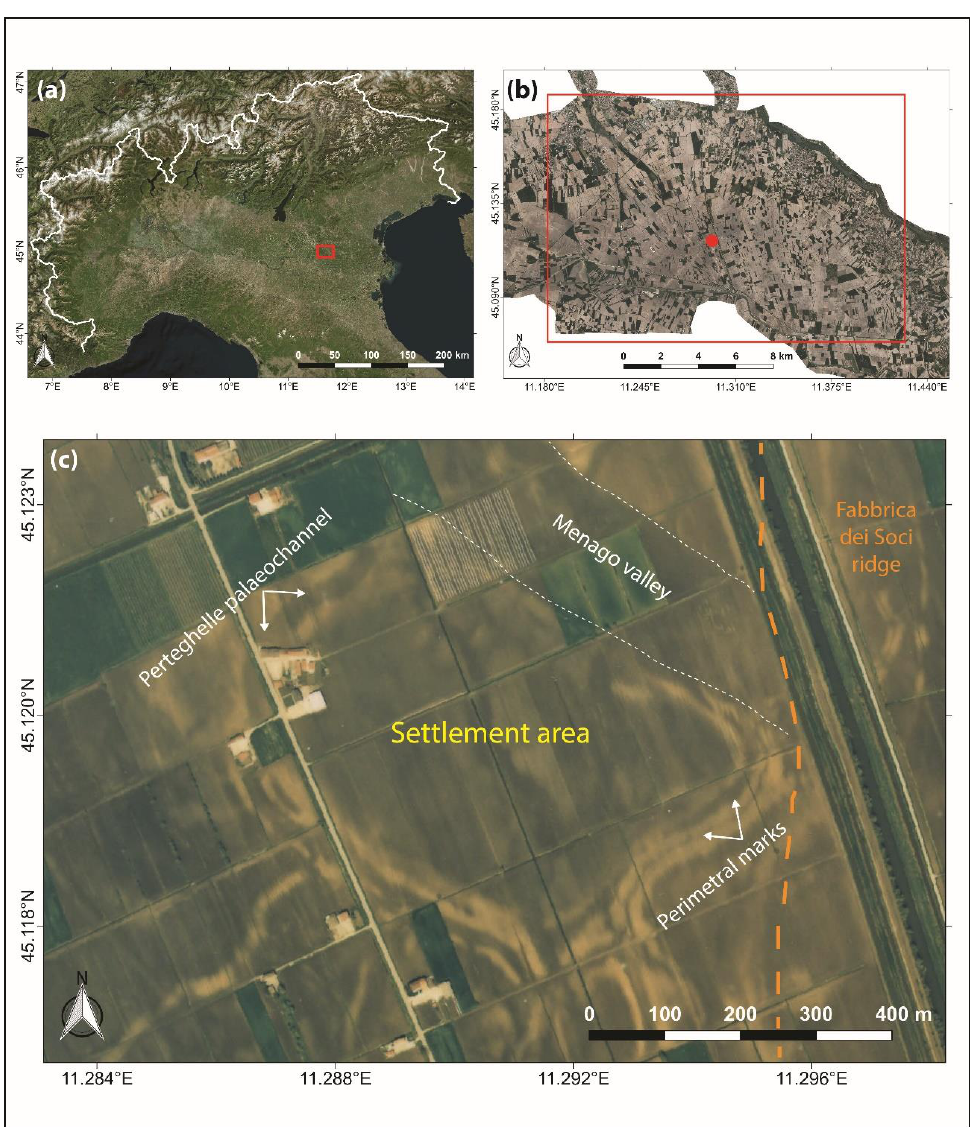
Figure 2. ( a ) Location of the embanked site of Fondo Paviani in Northern Italy (2020 aerial view from Maps-Bing modified by authors). ( b ) Fondo Paviani within the Valli Grandi Veronesi landscape (2012 photomosaic of C.G.R. aerial frames modified by authors). ( c ) Detail of the settlement landscape (1990 C.G.R. aerial frame modified by